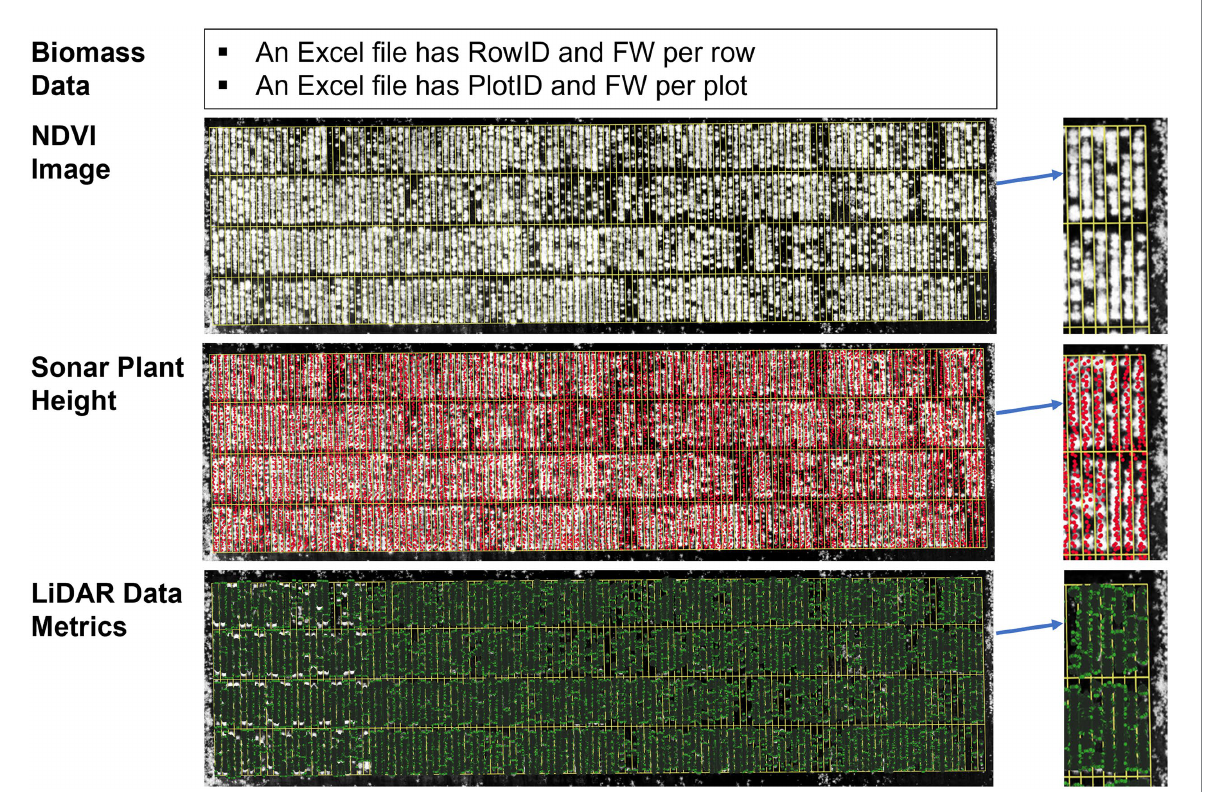
FIGURE 2 Each processed dataset consists of biomass data, normalized difference vegetation index (NDVI) image, Sonar plant height, and LiDAR data metrics (plant height, volume, and density) for each time point. In biomass data, the identity of each row and plot is classified in the RowID and PlotID columns versus its corresponding fresh mass (FM)